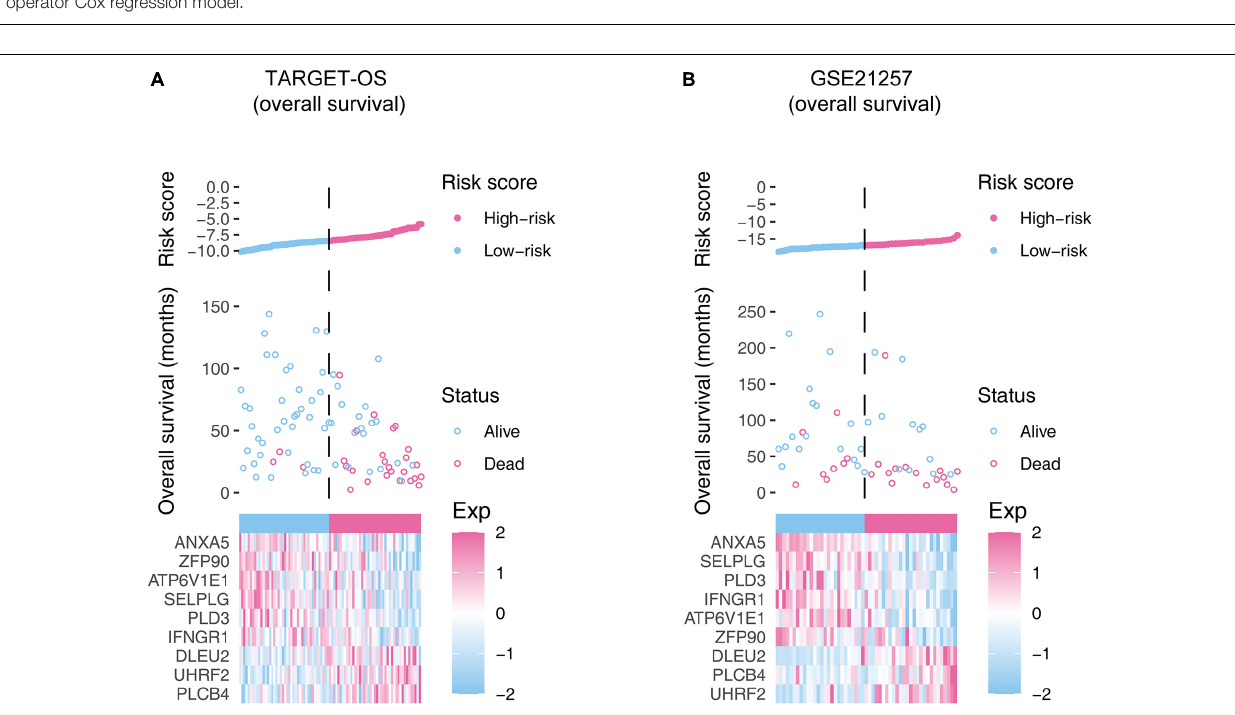
FIGURE 3 | LASSO regression analysis for the construction of a prognostic gene signature. (A) Cross-validation for tuning parameter screening upon LASSO regression analysis. (B) Screening of the optimal parameter (lambda) at which the vertical lines were drawn.LASSO, the least absolute shrinkage and selection operator Cox regression model.